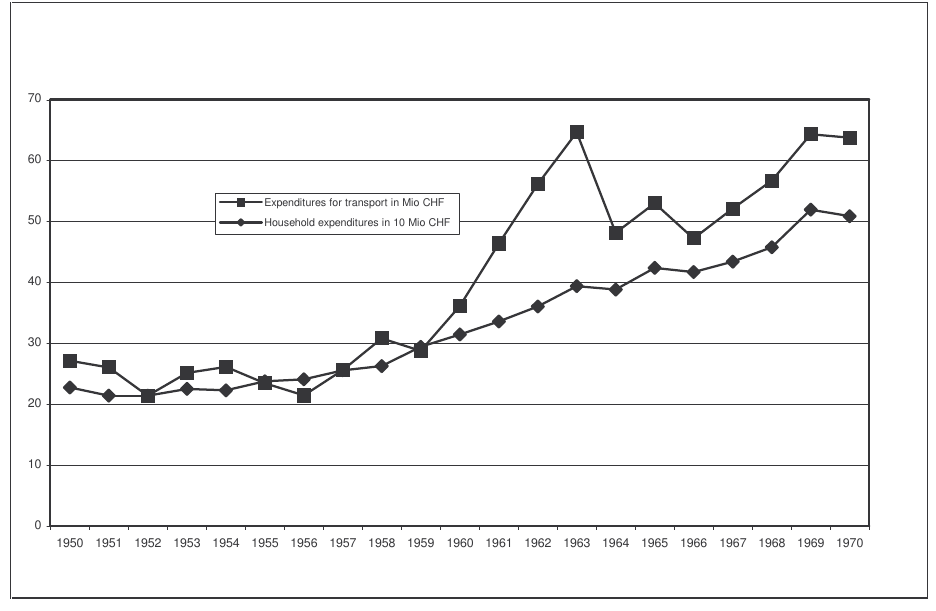
Figure 3. Expenditure on transport: City of Berne1950-70 (prices from1985) Sources: Gemeinde-Rechnung der Stadt Bern, div. vol., own calculations.